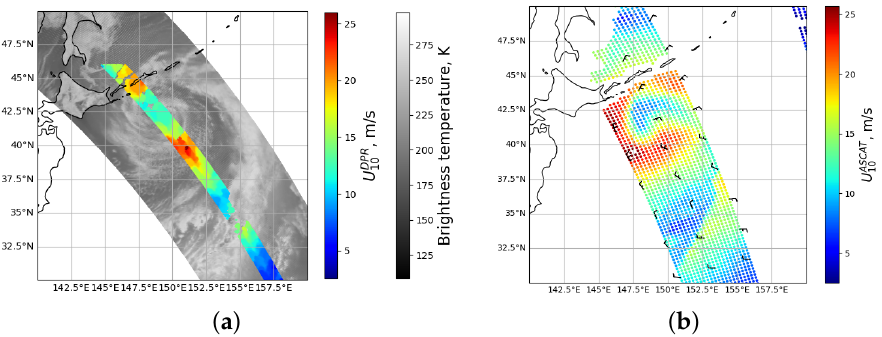
Figure 10. Wind speed from the DPR data over the image of brightness temperature from the GMI data at 89 GHz, V-polarization, tropical cyclone at 14:30 UTC on 31 January 2015 ( a ); wind field from ASCAT data at 12:30 UTC ( b ). The DPR track passes through the center of the cyclone. In Figure 11, the sections along the left side of the DPR swath for DPR (red dots) and ASCAT (black dots) wind speeds are presented. The data of the two radars are in good agreement. However, there is a gap in the ASCAT measurements near the isles, while DPR allows us to obtain the wind speed close to the